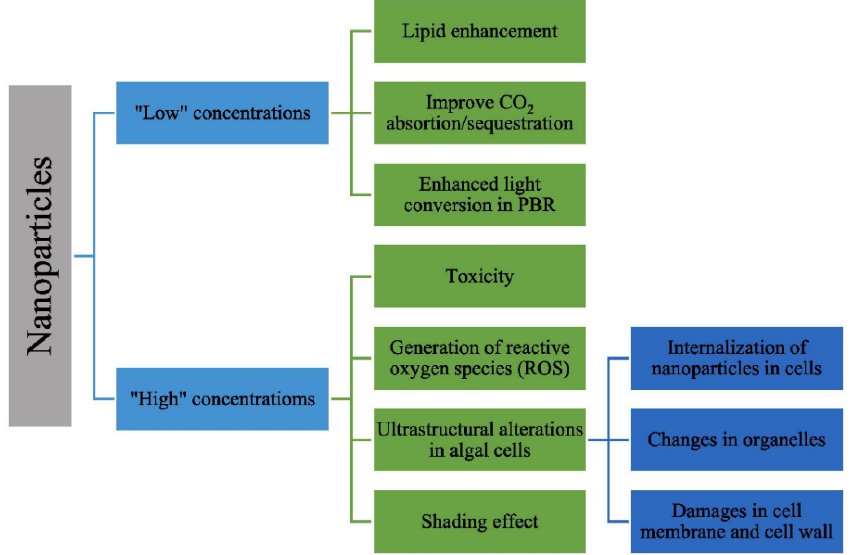
Figure 1. Effects of nanoparticles on microalgae (reprinted with permission of Elsevier) [63].